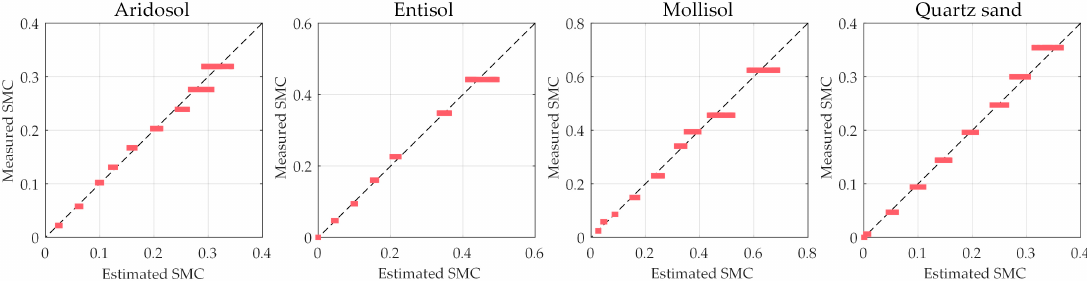
Figure 12. SMC measured and estimated using Equation (14).